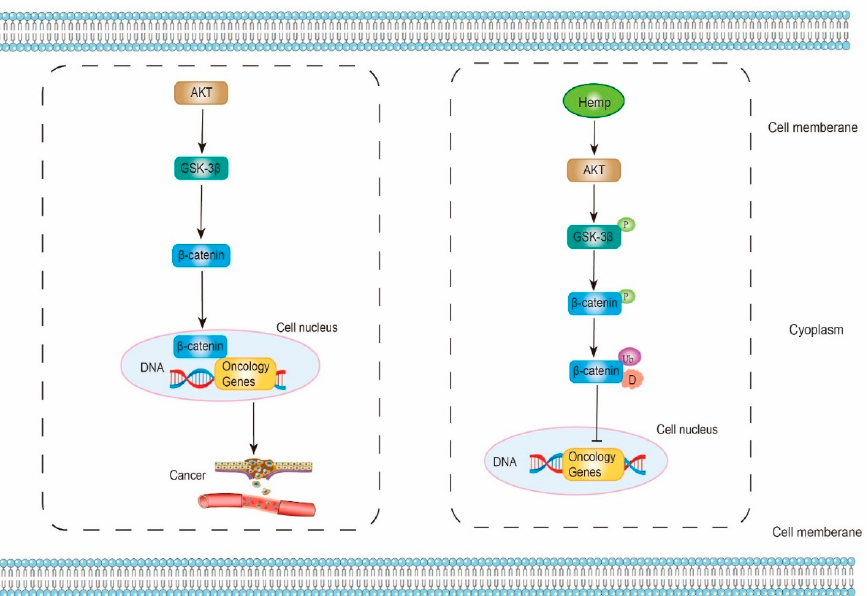
Figure 3. The mechanism of antioxidant and anti-inflammatory properties of hemp bioactive pep- tides on NF- κ B and Keap1-Nrf2 signaling pathway. ROS, reactive oxygen species; IKK β , inhibitor of κ B Kinase β ; NF- κ B, Nuclear Factor κ B; Keap1, Kelch-like ECH-associated protein 1; Nrf2, nuclear factor erythroid 2-related factor 2; ARE, antioxidant response elements; CAT, catalase; SOD, super- oxide dismutase; GPx, glutathione peroxidase; HO-1, Heme Oxygenase-1; P, phosphorylation; represents promote or active; represents inhibit or inactive.